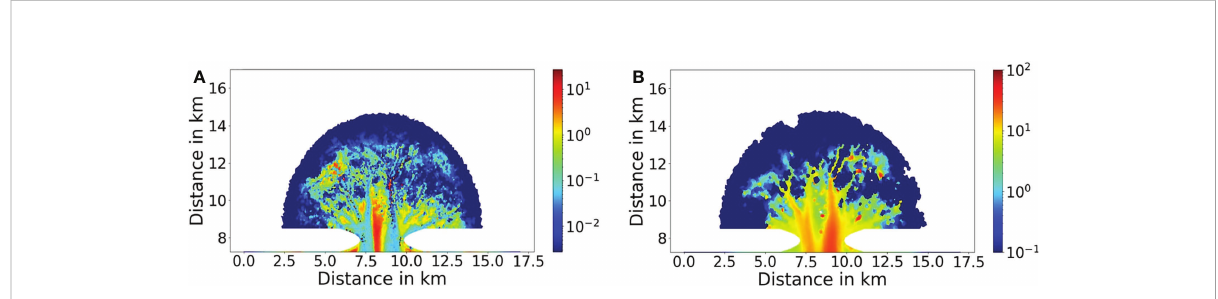
FIGURE 10 Bioturbation diffusivity ( A , unit: cm2 day-1) by bioturbators and bio-deposition rate ( B , unit: g m-2 day-1) by fi lter/suspension feeders in the Bio_all